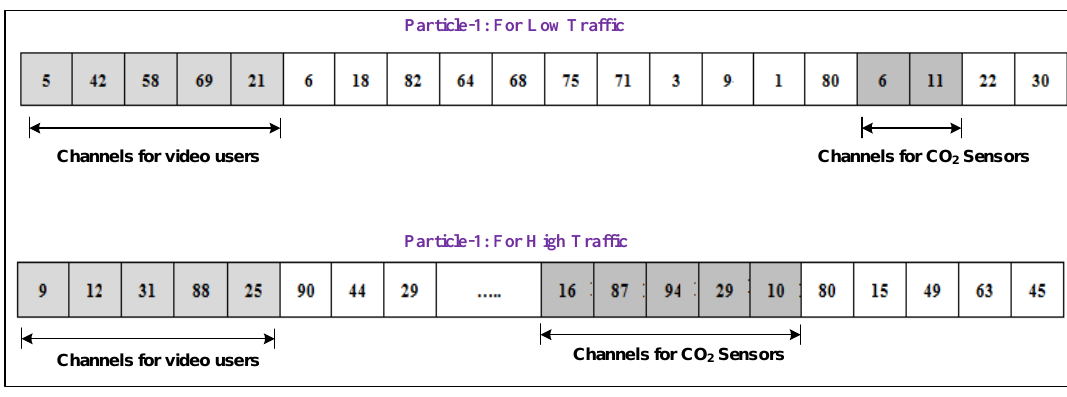
Figure 4. Particle